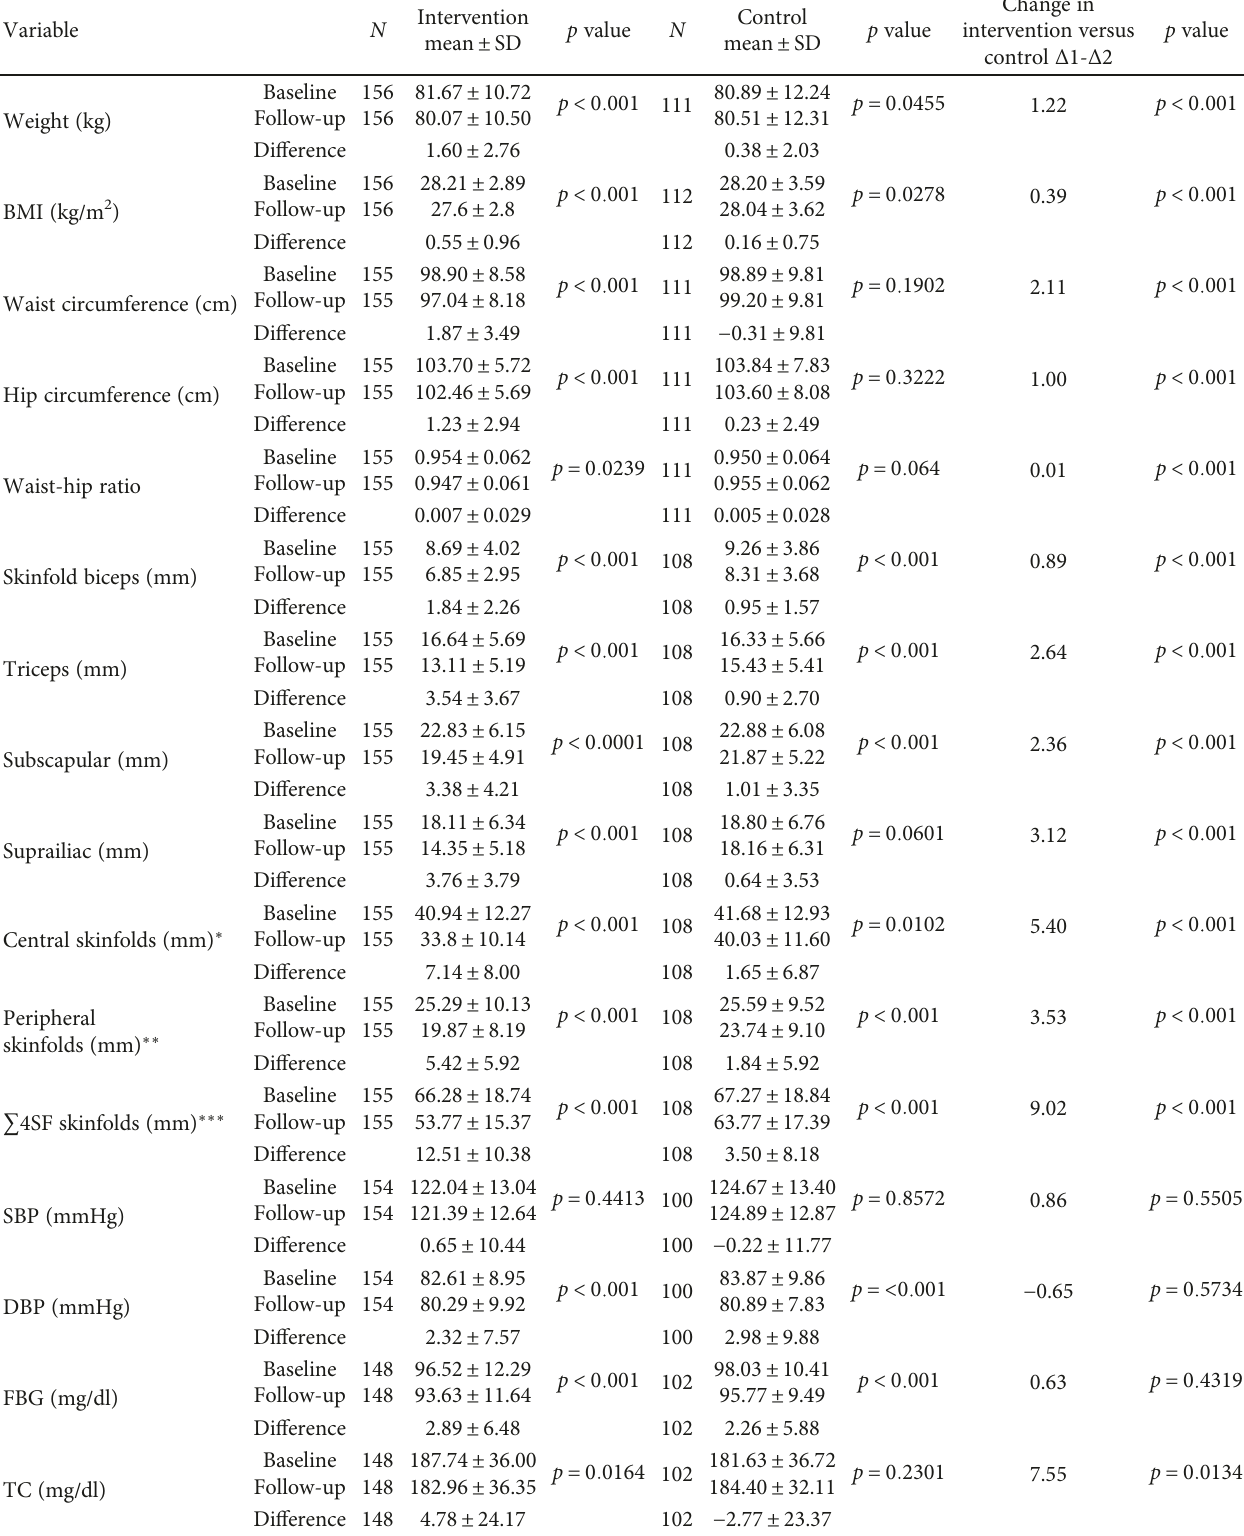
Table 4: Changes in values of body composition, blood pressure, and metabolic factors after intervention.